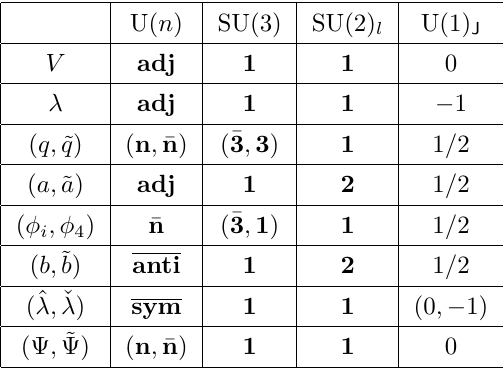
Table 2. The N = (0 , 2) multiplets and symmetries in ADHM formalism of 6d G 2 gauge theory. the matter content in table 2, one can write down the n -string elliptic genus: 1 Z = n n